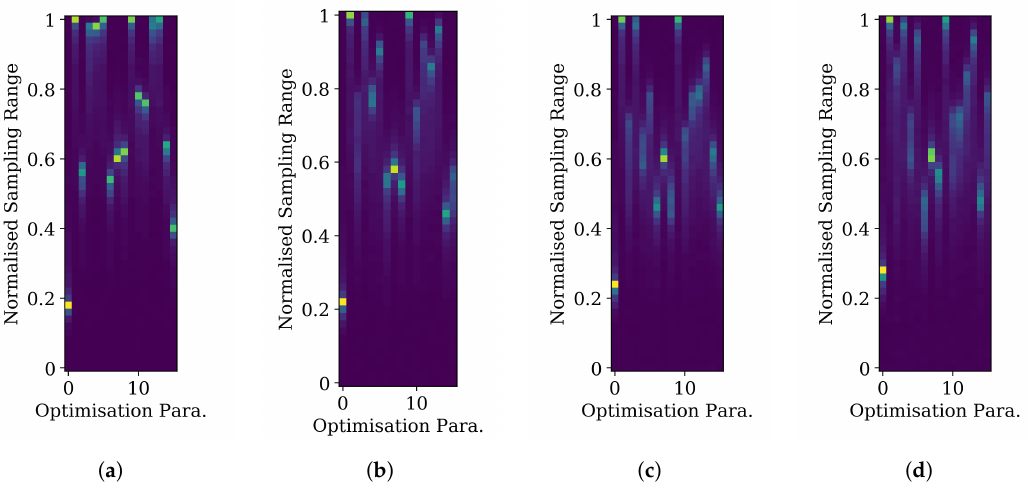
Figure A3. Comparison of the parameter distributions for adjusted parameter limits, with fixed Arrhenius parameters. Sampling ranges have individually been shifted upwards for the stuck parameters, in an effort to improve the overall fitness. Original sampling limits are shown in the left most plot, with successive shifts shown to the right. ( a ) T a,b,c P A,L 1 ,HC , ( b ) T a,b,c P A,L 1 ,HC L 1 , ( c ) T a,b,c P A,L 1 ,HC L 2 , ( d ) T a,b,c P A,L 1 ,HC L 3 .